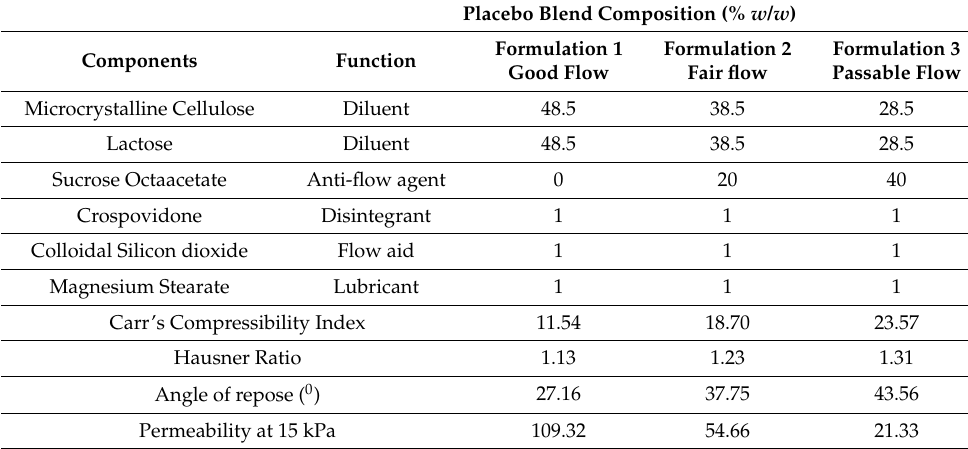
Table 1. Composition of placebo direct compression blends used to develop the process model and their flow